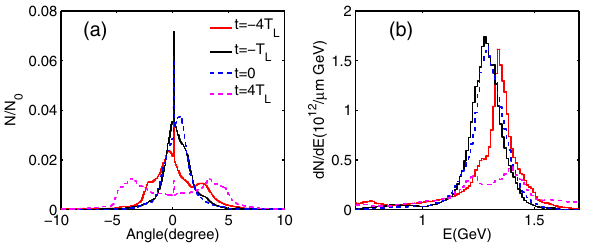
FIG. 9. The number density (normalized by the amount of statistical protons) angular distributions (a) and the energy spectra (b) of the proton with different arrival times of the auxiliary laser. In the four comparative simulations, the auxiliary laser pulse reaches the target at t ¼ − 4 T L , t ¼ − T L , t ¼ 0 , and t ¼ 4 T L , respectively. Here, we choose those protons who locate in the region − 4 μ m ≤ y ≤ 4 μ m as the objects of statistics. These snapshots are corresponding to the moment t ¼ 42 T L Fig. 9(a). For the t ¼ − T L and t ¼ 0 cases, the main and auxiliary lasers reach the foil almost simultaneously.